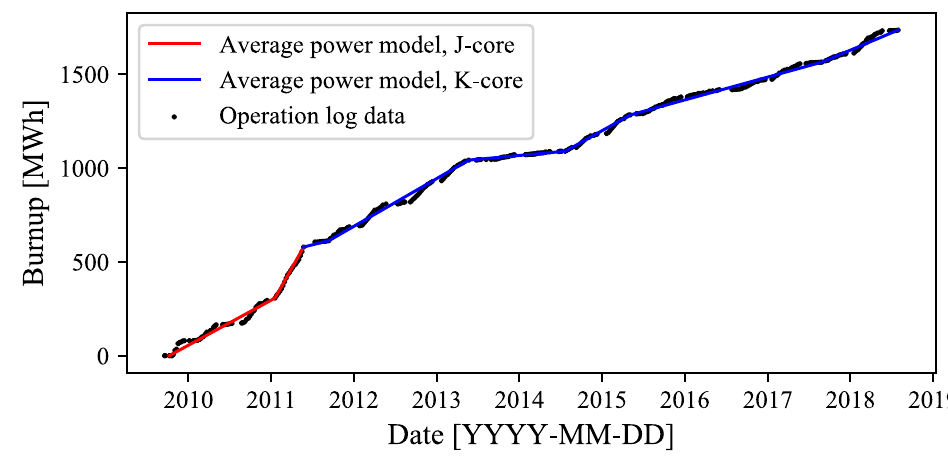
Figure 3: Simplified burnup input model with comparison to operation